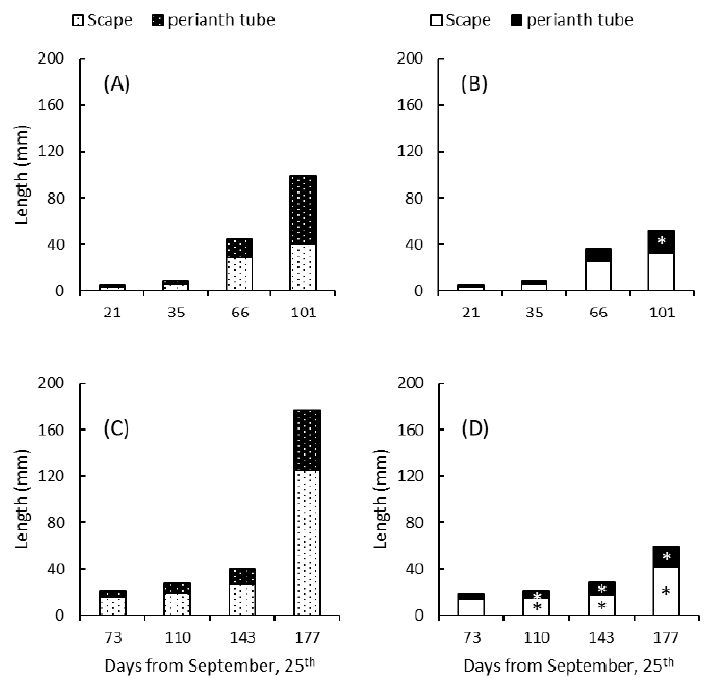
Figure 7. Variation in scape and perianth tube length in C. nevadensis ( A , B ) and C. vernus ( C , D ), when potted plants were grown at 10 °C ( A , C ) or exposed to a cooling period from 20 November 2010 to 20 January 2011 ( B , D ). * Significant differences in length as compared to those plants grown at 10 °C. Five plants per date and treatment were measured.